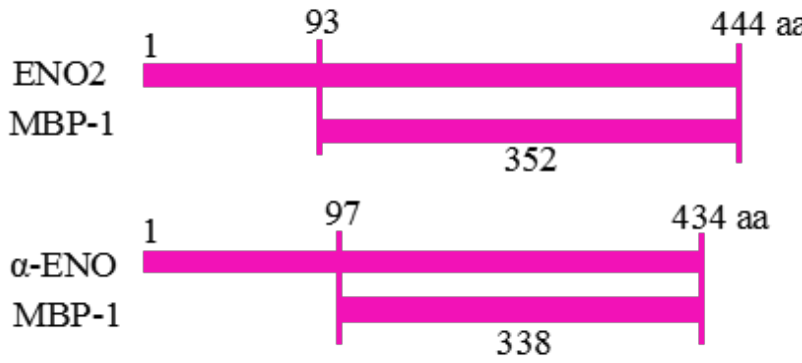
Figure 1. Diagram of ENO2/ α -ENO protein and the truncated form MBP-1. aa indicates amino acid.